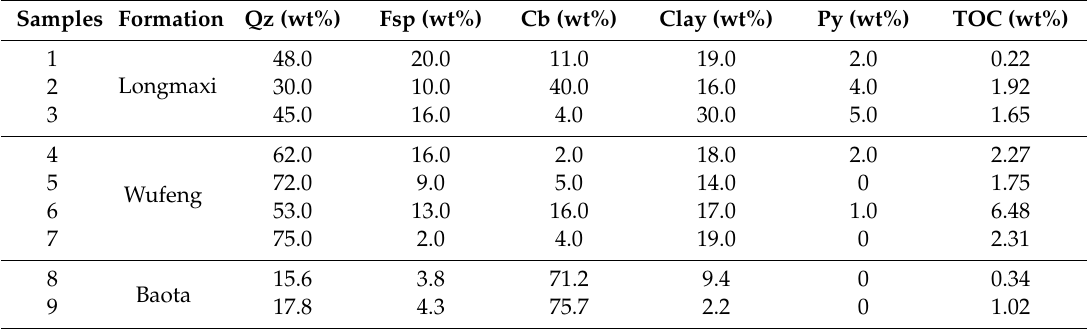
Table 1. Summary of measured compositional properties of tested samples. Qz (quartz), Fsp (feldspar), Py (pyrite), Cb (carbonate minerals), TOC (total organic carbon). Samples Formation Qz (wt%) Fsp (wt%) Cb (wt%) Clay (wt%) Py (wt%) TOC (wt%) Longmaxi